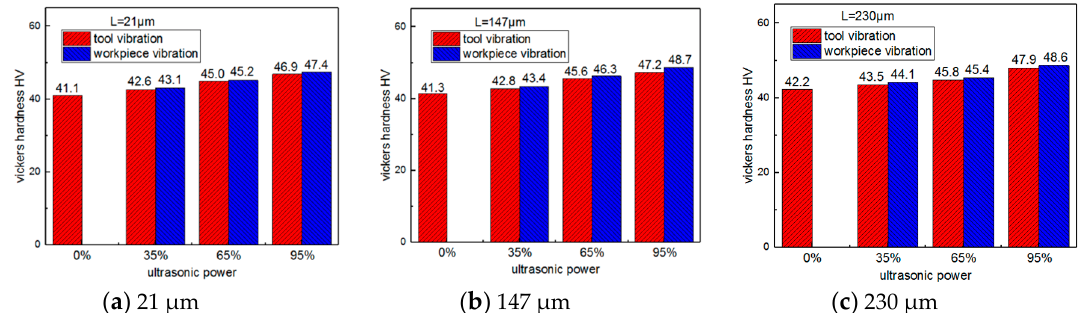
Figure 12. Cross section micro-hardness of micro-extruded specimen with different vibration modes.